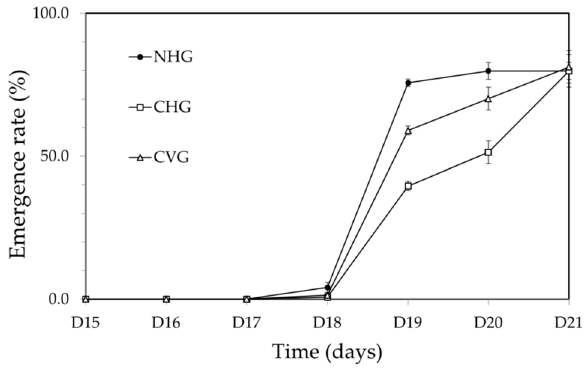
Figure 2. Emergence rates of each group from D15 to D21. NHG: the non-capped and horizontally oriented groups; CHG: the capped and horizontally oriented groups; CVG: the capped and vertically oriented groups.